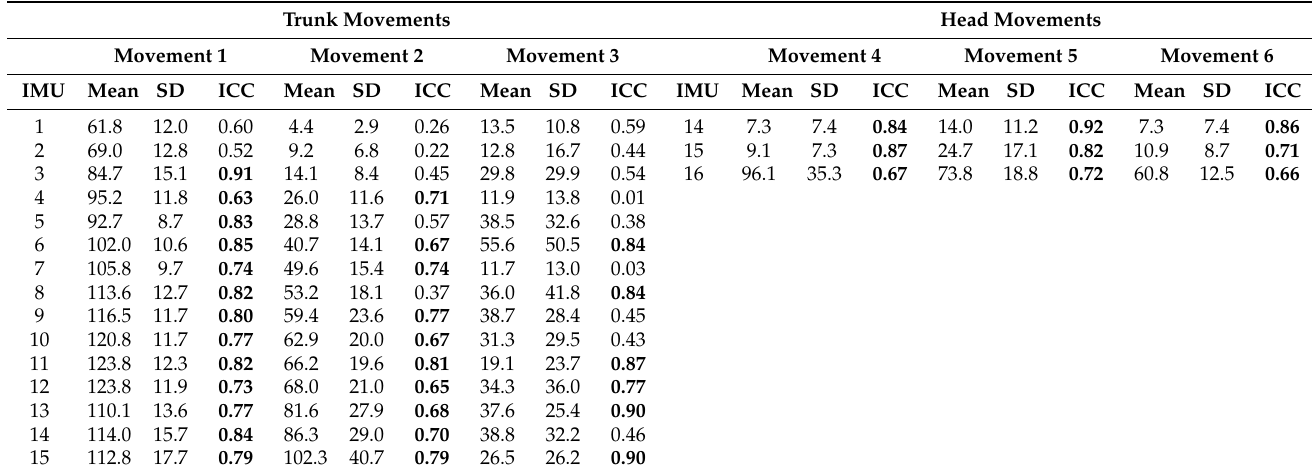
Table 2. Descriptive statistics and intraclass correlation of registered ranges of motion by the IMUs for the MIMUs for the trunk and head movements, considering two repeated series of three movements by the same